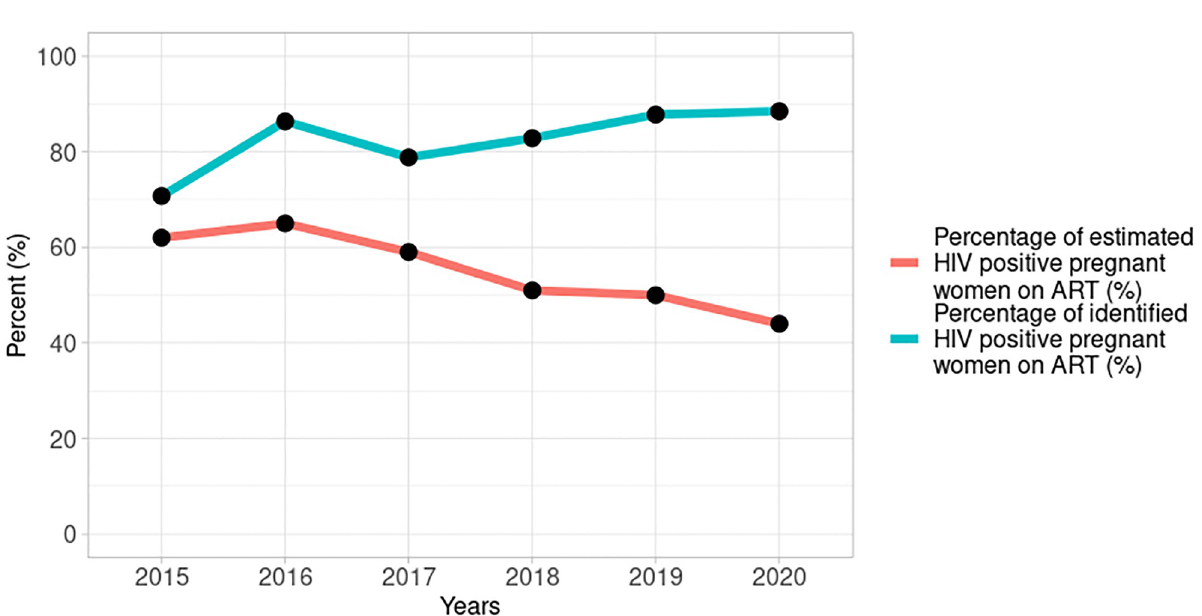
PLOS Global PublicHealth | https://doi.org/10.1371/journal.pgph.0001749 April 4,